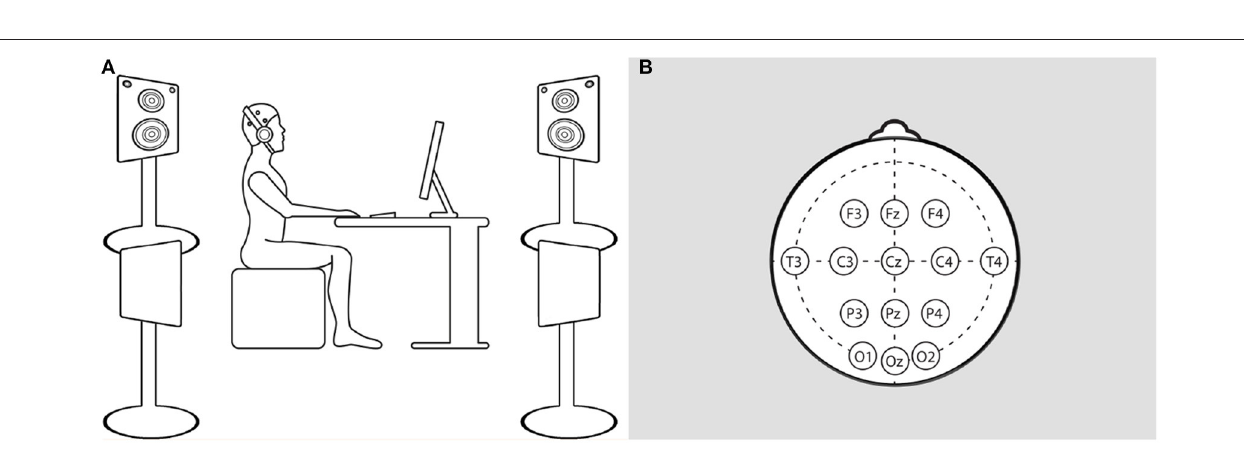
FIGURE 2 | Schematic presentation of the participants’ seating position (A) and the electrode setup of EEG cap (B) . It should be noted that on the left illustration (A) , the height of the loudspeakers was adjusted for display purposes but, as mentioned, was actually 1.0 m from the floor. (B) The distribution of applied electrodes on the